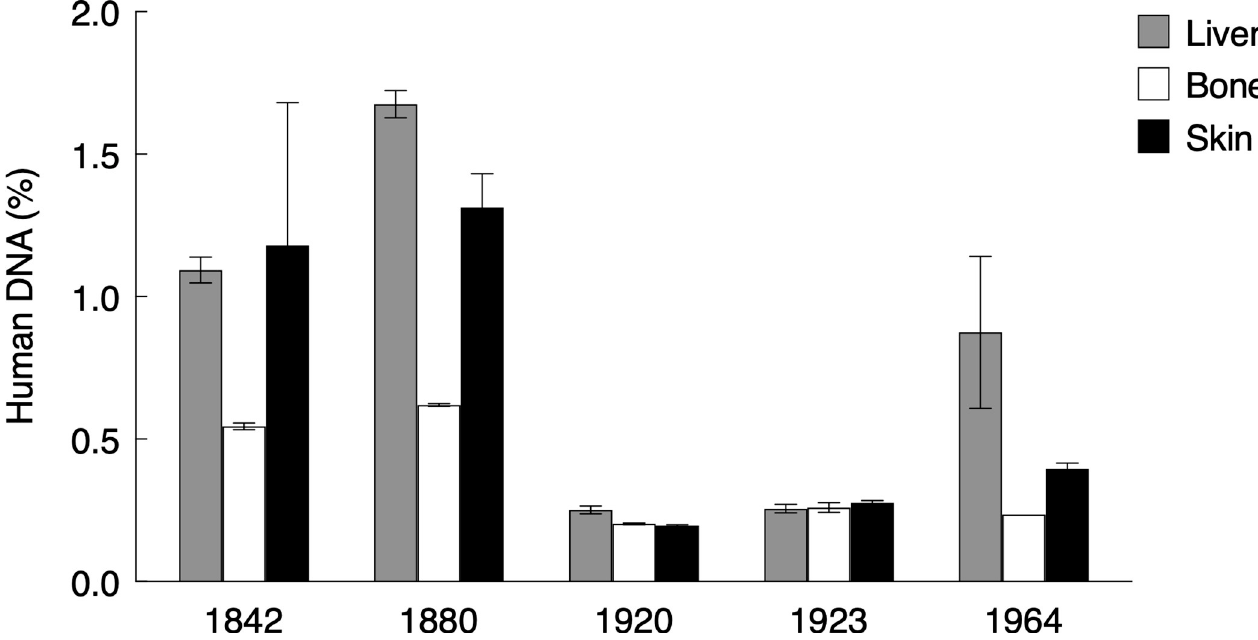
Fig 2. Human DNA contamination. Fraction of sequences that could be mapped to the human reference genome listed according to specimen age. Bars represent average values of two replicate DNA extracts and the range is shown.